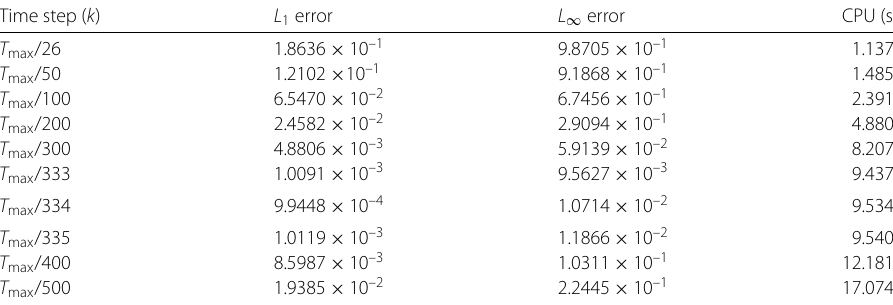
Table 9 L 1 and L ∞ errors and CPU time at some different values of time-step size, k for Problem 2 at time 2.5 × 10 –3 with spatial mesh size, h = 0.01, (cid:5) = 0.01 using NSFD- (cid:5) scheme, T max = 2.5 × 10